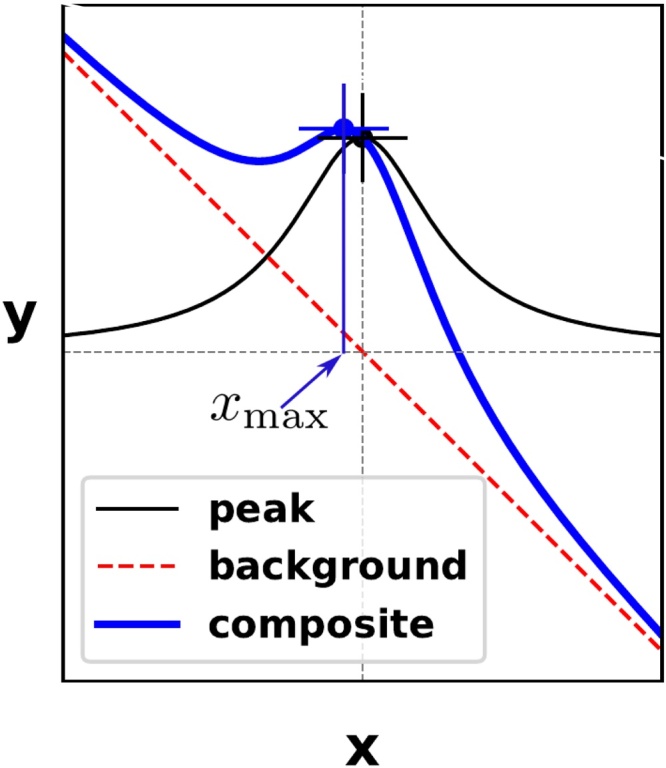
The shift of a Lorentzian peak's (black solid line) maximum location when applied on the top of a slope (red dashed line) (see Eq. (B.1) with A = 2.5, a = 1). Black crosshair is positioned at the maximum of the Lorentzian peak. Blue crosshair is positioned at the maximum of the composite (Lorentzian + linear) function (blue solid line).